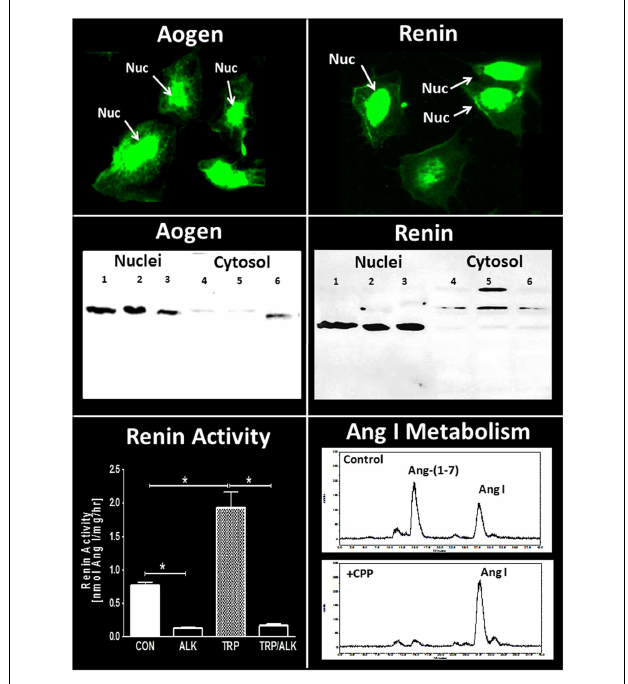
FIGURE 3 | Expression of intracellular components of the renin-angiotensin system in NRK-52E renal epithelial cells . Immunofluorescent (IMF) staining and protein immunoblot for rat angiotensinogen (Aogen) and renin. Immunoblots of Aogen and renin in nuclei (lanes 1–3) and cytosol (lanes 4–6) were from three separate passages of NRK-52E cells. Major bands for Aogen and renin were identified at approximately 55kDa. Renin activity (conversion of Aogen to Ang I) in isolated nuclear fractions was increased threefold following activation by trypsin (TRP) and was essentially abolished by the renin inhibitor aliskiren (ALK). Conversion of 125 I-Ang I to 125 I-Ang-(1–7) in the isolated nuclear fraction was predominantly blocked by the thimet oligopeptidase inhibitor CPP. Renin activity data are mean ± SEM; n = 4; * P < 0.05. Ang I metabolism representative of data from n = 4 separate cell passages. Adapted from Alzayadneh and Chappell